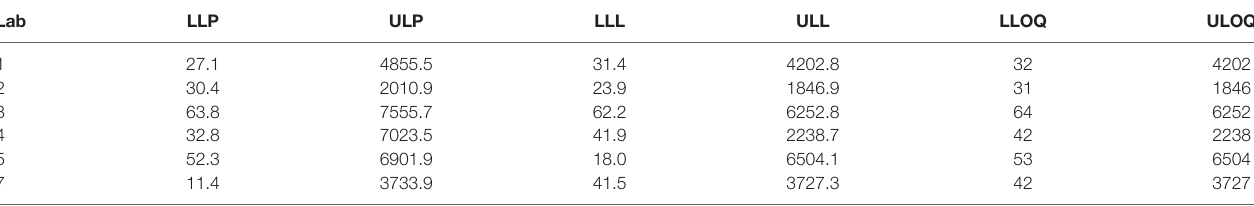
Lower and upper limits of precision (LLP and ULP), lower and upper limits of linearity (LLL and ULL), and lower and upper limits of quantitation (LLOQ and ULOQ) are shown for each laboratory. LLOQ and ULOQ de fi ne the range in which the FLUCOP ELLA-NI SOP delivers both precision and linear accuracy for the testing